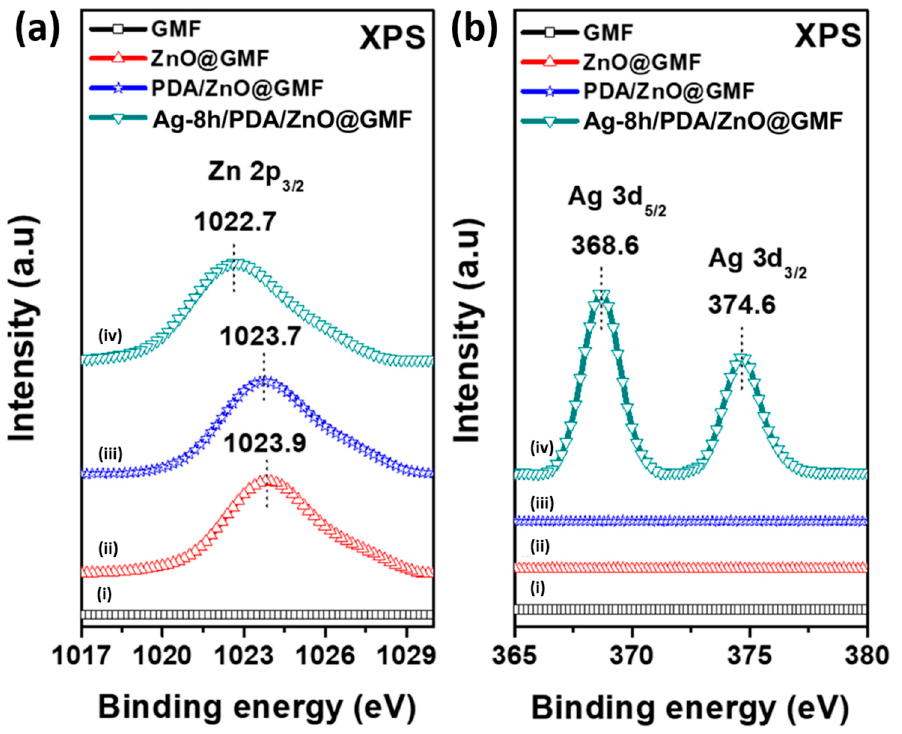
Figure 2. X-ray photoelectron spectroscopy of ( a ) Zn 2p 3/2 , ( b ) Ag 3d 5/2 and Ag 3d 3/2 -(i) glass fiber filter paper, (ii) zinc oxide substrate, (iii) polydopamine deposited on zinc oxide substrate, (iv) polydopamine reduced silver nanoparticles on zinc oxide substrate.